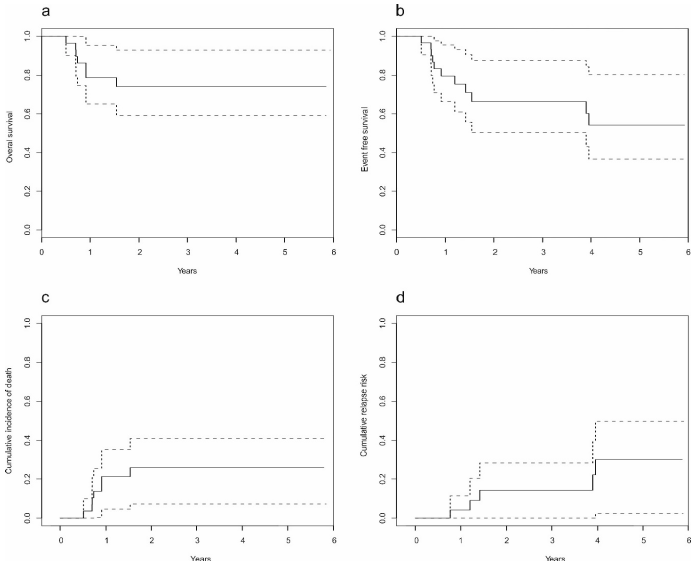
Figure 1. Analysis of the entire cohort of children with ALL Ph+: ( a ) overall survival; ( b ) event-free survival; ( c ) cumulative incidence of deaths; ( d ) cumulative incidence of relapse. Solid line in the figure represents cumulative incidence, while dotted lines represent upper and lower confidence interval (95%) for this cumulative incidence.